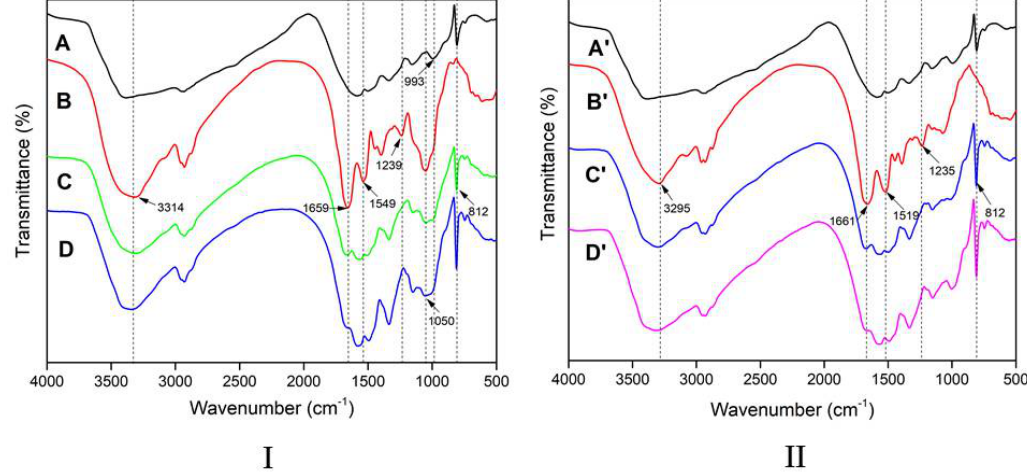
Figure 7. FTIR spectra of the samples: ( I ) (A (HMP), B (SF adhesive), C (SF/9% HMP adhesive), and D (SF/18% HMP adhesive)) and ( II ) (A’ (HMP), B’ (SPI adhesive), C’ (SPI/9% HMP adhesive), and D’ (SPI/18% HMP adhesive)).